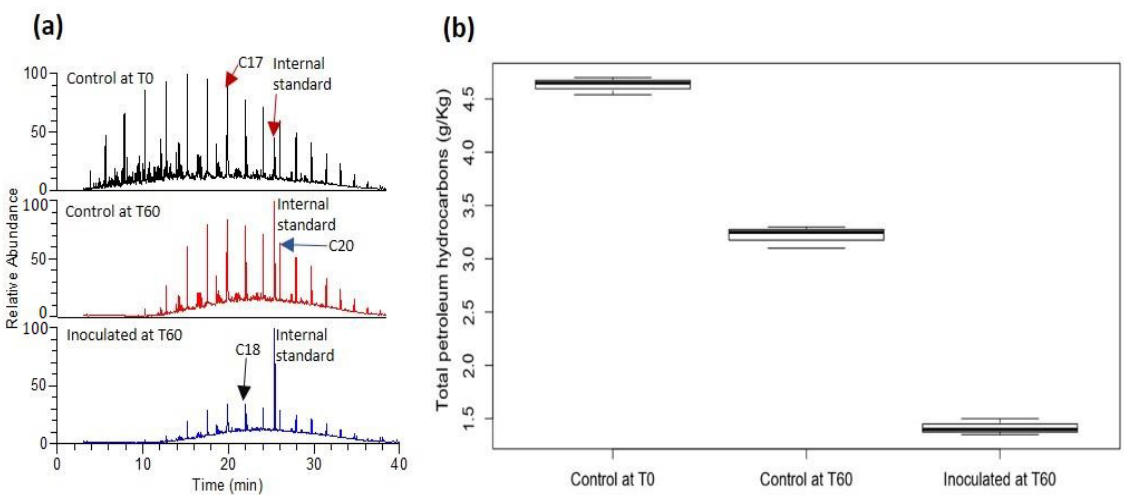
Figure 5. ( a ) Gas chromatography-mass spectrometry (GC-MS) chromatograms (total ion current) showing the relative abundance of nominal diesel fuel hydrocarbons, and residual hydrocarbons after 60 days for control and microbial-inoculated samples. The number associated with each peak represent the number of carbon atoms. ( b ) Boxplot showing nominal total hydrocarbons (Control at T0) and residual total petroleum hydrocarbons after 60 days, under different treatments. Table 1. Statistical parameters for the one-way analysis of variance. Linear Hypothesis (Tukey